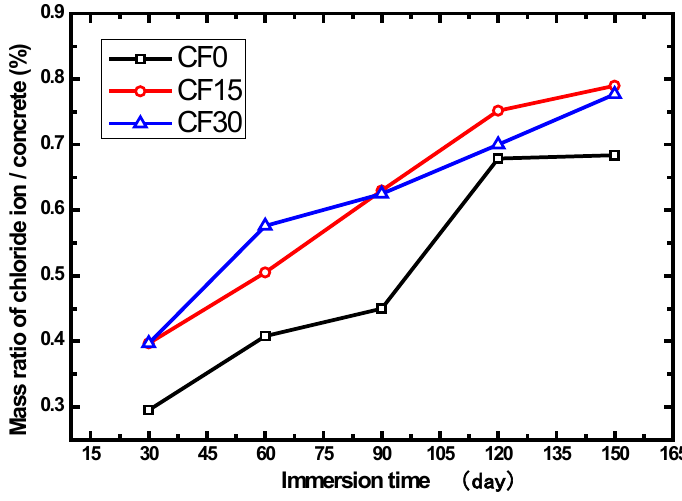
Figure 1. Correlation between the fly ash and chloride ion content in the surface layer of concrete.